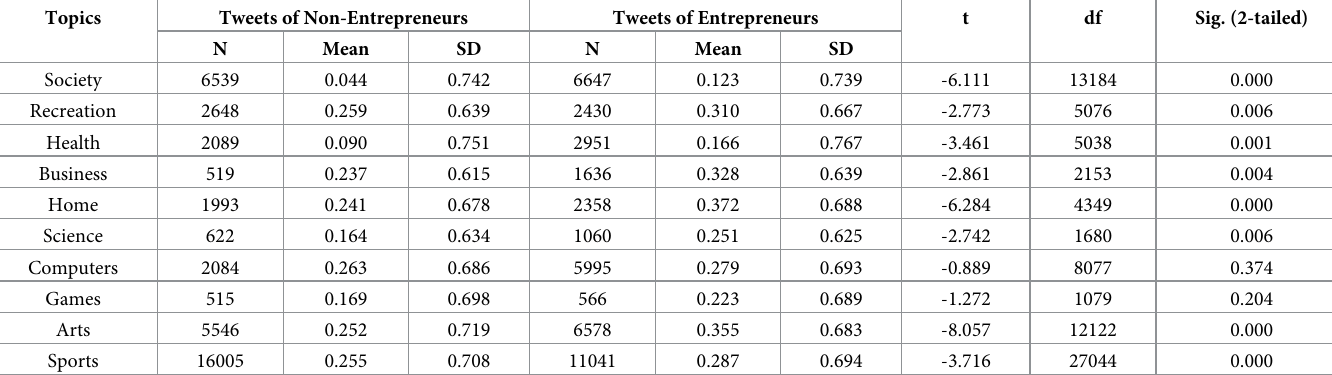
Table 7. Two-sample t-test to compare the mean emotional score per topic between entrepreneurs and non-entrepreneurs (London data).